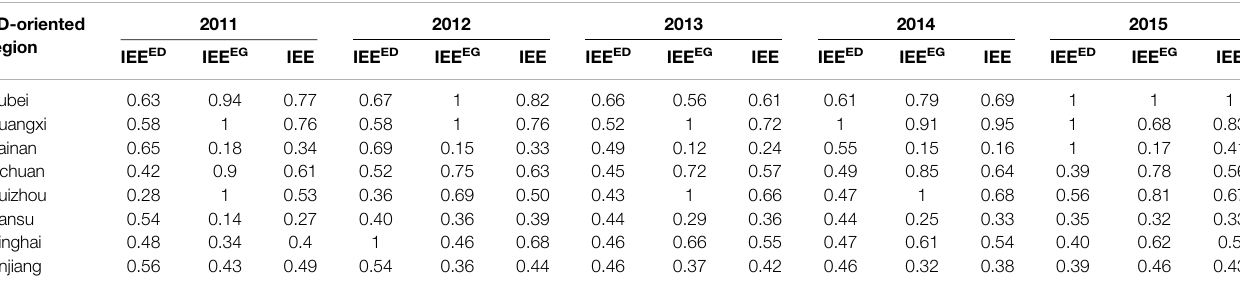
TABLE 4 | IEE of ED-oriented provinces. ED-oriented region